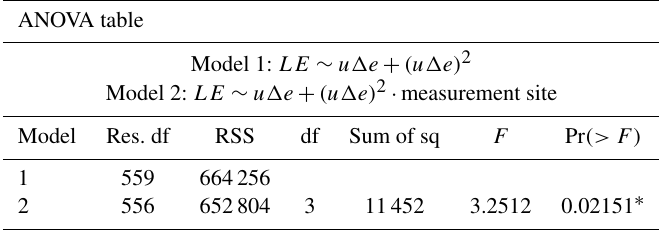
Table E1. An Analysis of variance (ANOVA) test indicating the significant difference ( p < 0 . 05) of the hourly model coefficients found between the two measurement sites during the summer of 2019.